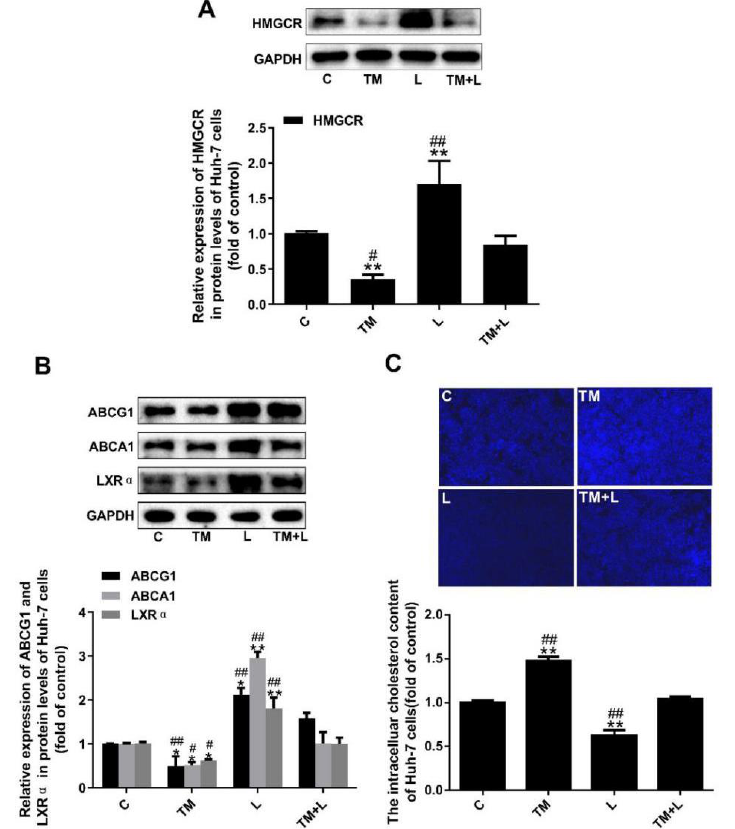
Figure 5. Tunicamycin-induced ER stress reduced cholesterol efflux in Huh-7 cells, and LXR-623 inhibited this effect. ( A ) Expression levels of HMGCR in Huh-7 cells. ( B ) Expression levels of ABCA1, ABCG1 and LXRα in Huh-7 cells. ( C ) Intracellular cholesterol measured by filipin staining. C, control; TM, tunicamycin; L, LXR-623; TM + L, tunicamycin + LXR-623. Data are shown as the mean ± SD ( n = 3), * p < 0.05 or ** p < 0.001 versus the C group. # p < 0.05 or ## p < 0.001 versus the TM + L group.